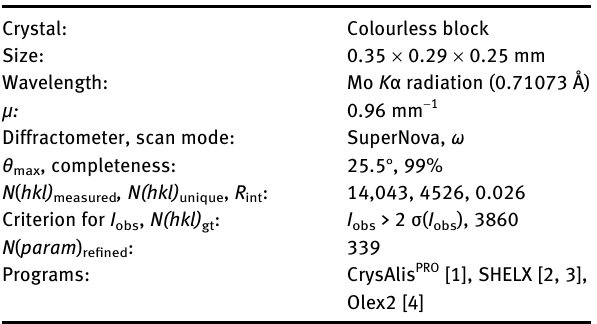
Table 1 contains crystallographic data and Table 2 contains the list of the atoms including atomic coordinates and displacement parameters.